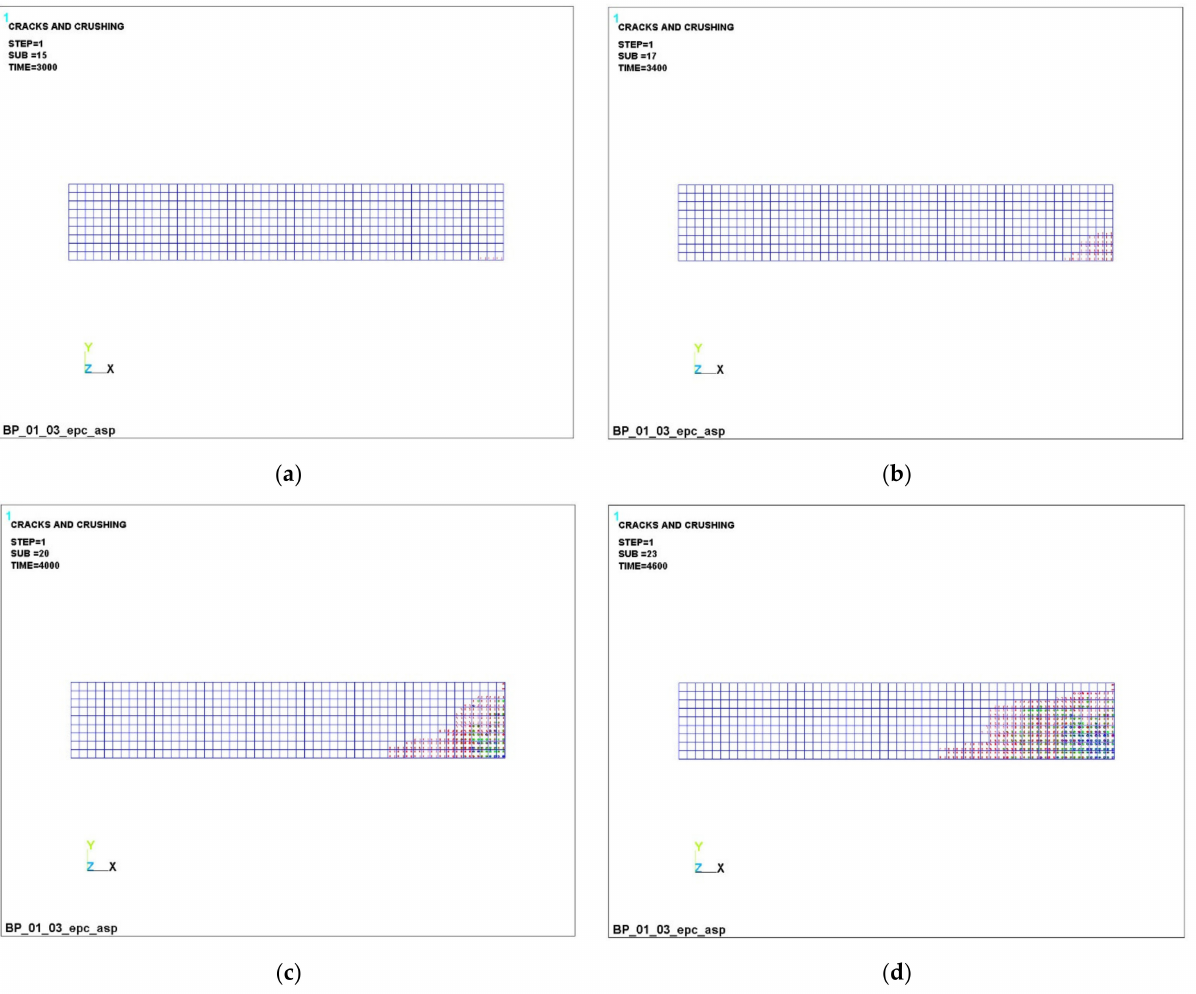
Figure 8. Successive cracking in concrete with GCR under load: ( a ) –3000 N; ( b ) –3400 H; ( c ) 4000 H; ( d ) –4600